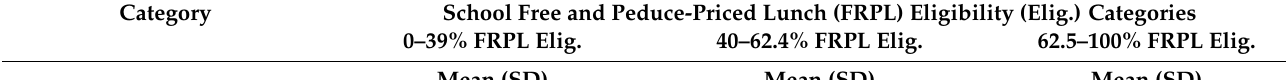
Table 3. Food need and access by schools.